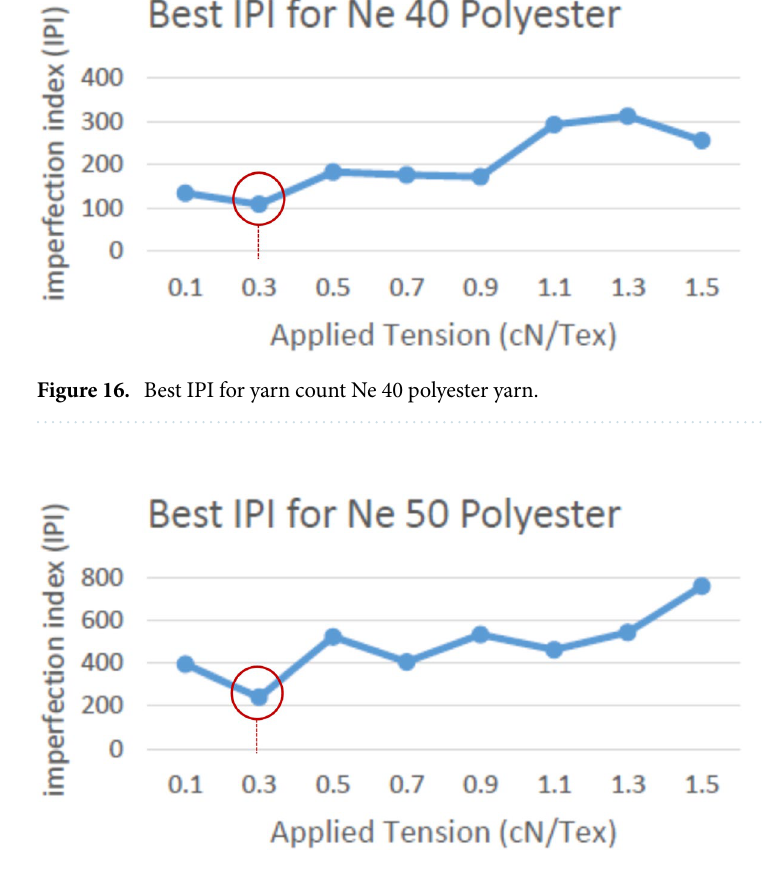
Figure 17. Best IPI for yarn count Ne 50 polyester yarn.